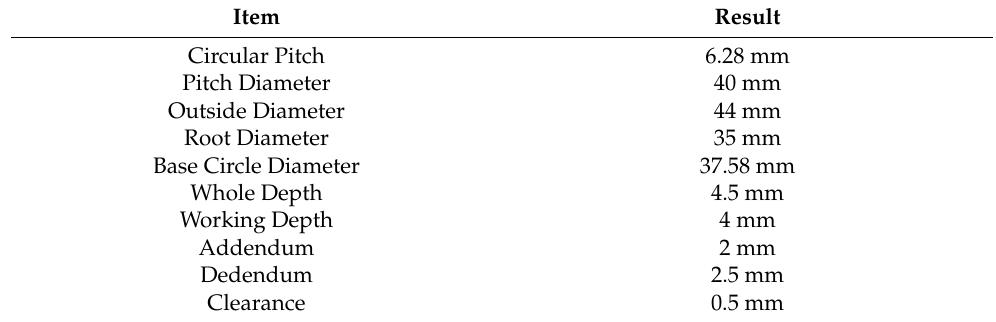
Table 19. System